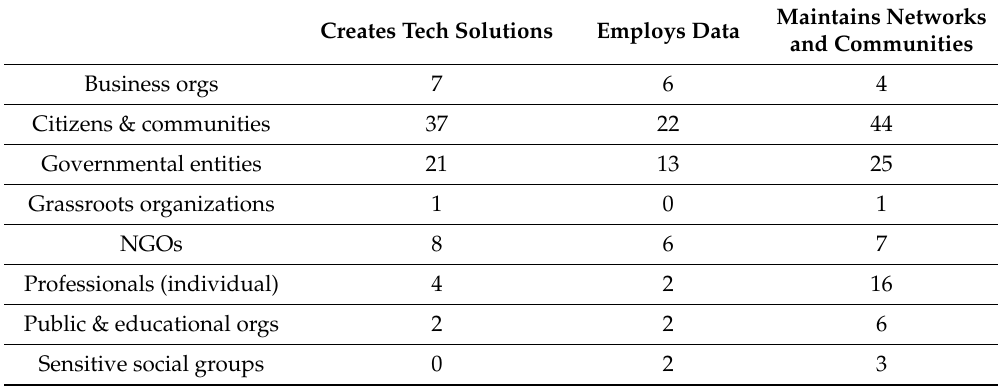
Table 7. The Distribution of Platforms in the Sample Based on Methods and Target Groups